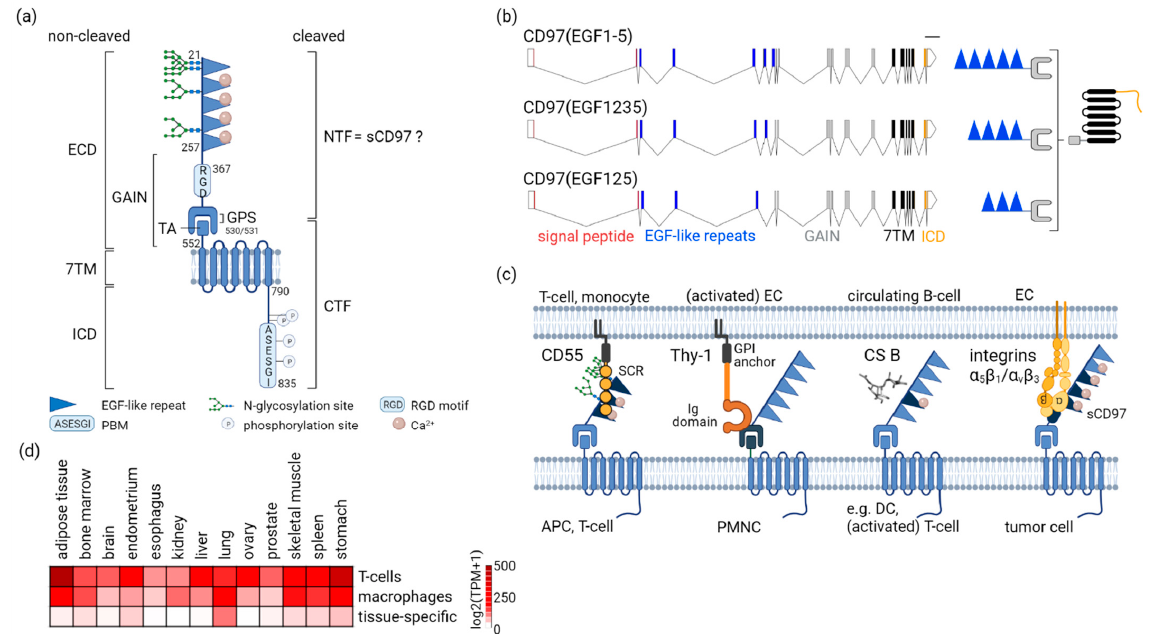
Figure 1. Common features of human CD97 . ( a ) Schematic structural organization of CD97. The figure depicts the 835 amino acid full-length CD97(EGF1-5) isoform without the signal peptide. CD97 has a tripartite structure with the ECD, containing tandemly-arranged EGF-like repeats and the GAIN domain, the 7TM helices, and the ICD. The potential N-glycosylation sites in the EGF-like repeats are indicated. EGF2-5 can bind Ca 2+ , which is important for CD97 interactions. CD97 is self-cleaved at the GAIN domain-covered GPS, resulting in a bipartite structure with the NTF and CTF. Circulating sCD97 likely is the released NTF. The N-terminus of the CTF represents the integrated TA sequence. The ICD contains many phosphorylation sites. Four are confirmed in more than five records in which this modification was assigned using proteomic discovery mass spectrometry (phosphosite.org, accessed on 04 February 2022). In CD97(EGF1-5), these sites are S818, T825, S831, and S833. The ICD ends up in a PBM. For abbreviations and further explanations, see the running text. ( b ) Exon/intron and protein structure of the three CD97/ ADGRE5 isoforms. Alternative splicing results in isoforms with three to five EGF-like repeats with distinct binding properties. The isoforms are named CD97(EGF125), EGF(1235), and EGF(1-5), according to the EGF-like repeats present (wormweb.org, accessed on 15 March 2022). Intron: line; exon: solid bar; 5 ′ /3 ′ -UTR: empty bar; signal peptide: red; EGF-like repeats: blue; GAIN: grey; 7TM: black; ICD: orange; scale bar: 1000 base pairs ( c ) Interaction partners with the CD97 ECD. CD55 is a glycophosphatidylinositol (GPI)-anchored transmembrane receptor with four short consensus repeats (SCRs). The first three SCRs interact with at least three EGF-like repeats of CD97. Thy-1/CD90 is a small, heavily N-glycosylated GPI-anchored transmembrane receptor with a single extracellular immunoglobulin (Ig) domain. Thy-1 binding to CD97 on polymorphonuclear cells (PMNC) is calcium-independent and occurs through the GAIN domain. Binding to the glycosaminoglycan side chain chondroitin sulfate B (CS B), a component of the extracellular matrix and of cell surfaces proteoglycans, is mediated by the fourth EGF-like repeat of CD97. Thus, CS B interacts only with CD97(EGF1-5). Binding is Ca 2+ -dependent. Soluble recombinant CD97 interacts with integrins on endothelial cells (ECs) via its RGD motif and at least three EGF-like repeats. CS B can act synergistically. Interacting domains are indicated in dark blue. ( d ) ADGRE5 scRNAseq analysis in healthy normal human tissues. The analysis comprises all protein-coding genes in 144 individual cell type clusters (The Human Protein Atlas, proteinatlas.org; accessed on 07 February 2022). In the heat map, only tissues containing the clusters “T-cells” and “macrophages” are considered. Additionally, the tissue-specific cell type cluster with the highest ADGRE5 level is included (e.g., fat/adipocytes, lung/alveolar cells type 2, endometrium/smooth muscle cells, spleen/plasma cells, stomach/gastric mucus-secreting cells). Log2 transcripts per million (TPM) + 1 values are given. The figure was created with BioRender.com (accessed on 26 April 2022).